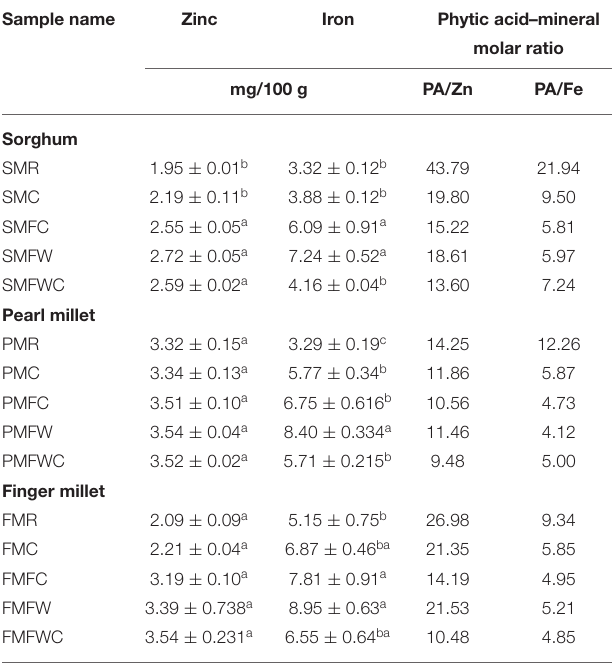
TABLE 2 | Mineral content and phytic acid–mineral molar ratio of traditionally processed sorghum, pearl millet, and finger millet